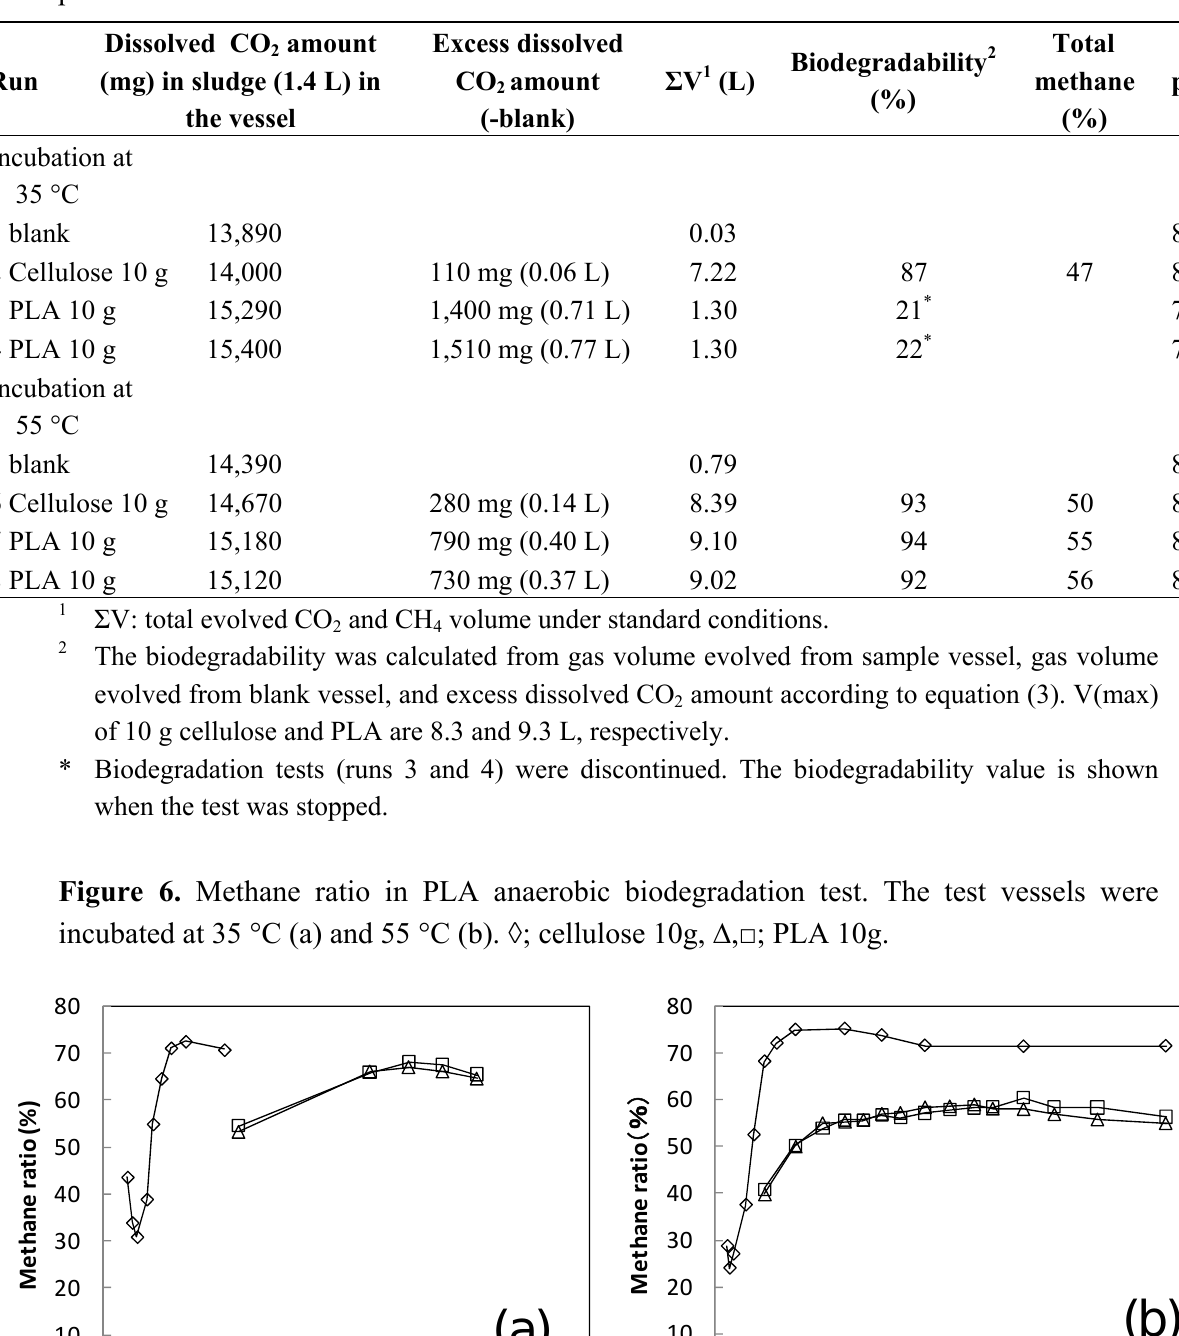
Table 3. Dissolved CO amount in the sludge, biodegradability, pH and total methane ratio 2 at the end of the anaerobic biodegradation of cellulose and poly(lactic acid) (PLA) powders.